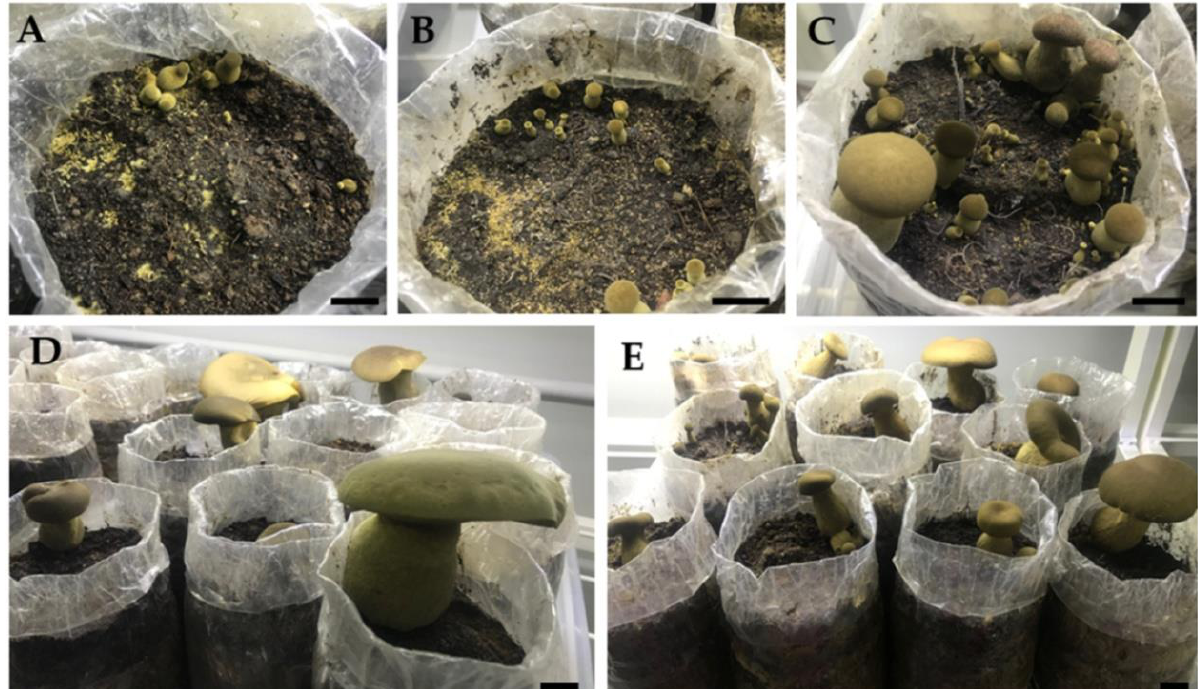
Figure 4. Fruiting body production of P. spongiosus in cropping room. Primordial formation after 10 – 15 days of incubation ( A , B ). Primordia develop to young fruiting bodies ( C ). Yong fruiting bodies develop to mature fruiting bodies within one week ( D , E ). Scale bar = 1 cm. Table 3. Fruiting body size of P. spongiosus resulting from the cultivation process and high-voltage pulsed stimulation.